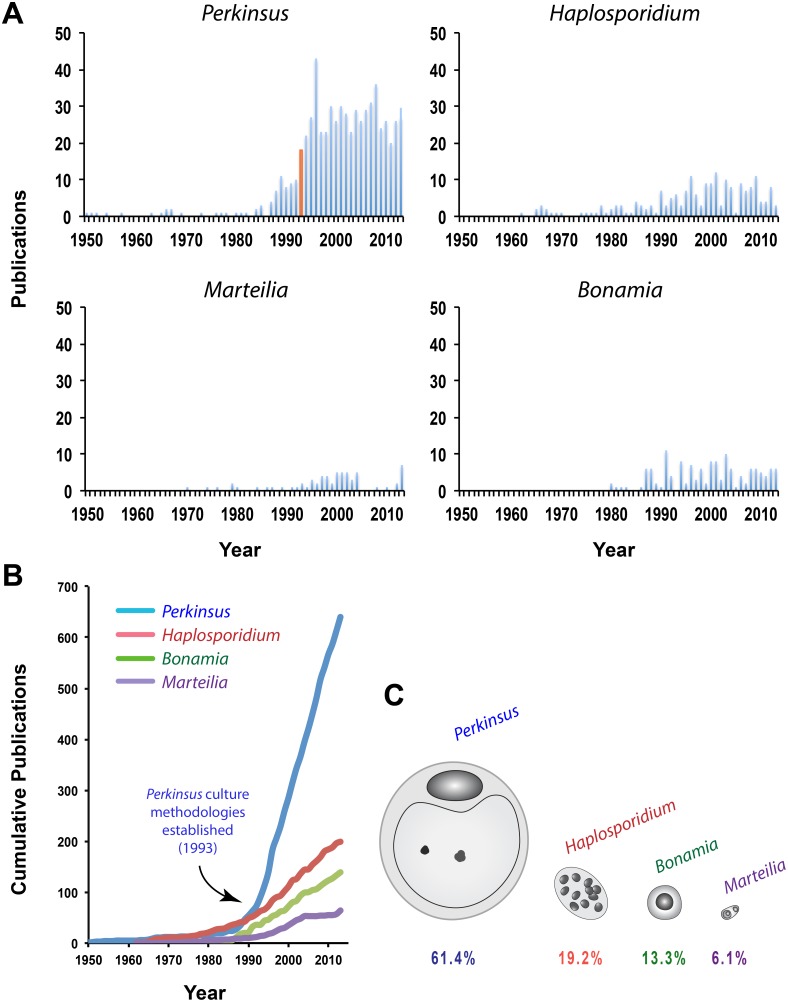
Number of papers in the literature (SCOPUS Database) reporting in the genera Perkinsus, Haplosporidium, Marteilia, and Bonamia; column in orange correspond to 1993, the year when the methodologies for culturing Perkinsus were published (A). Cumulative papers over the same period of time (B). Percent of the literature reporting each particular protozoan parasite (C).